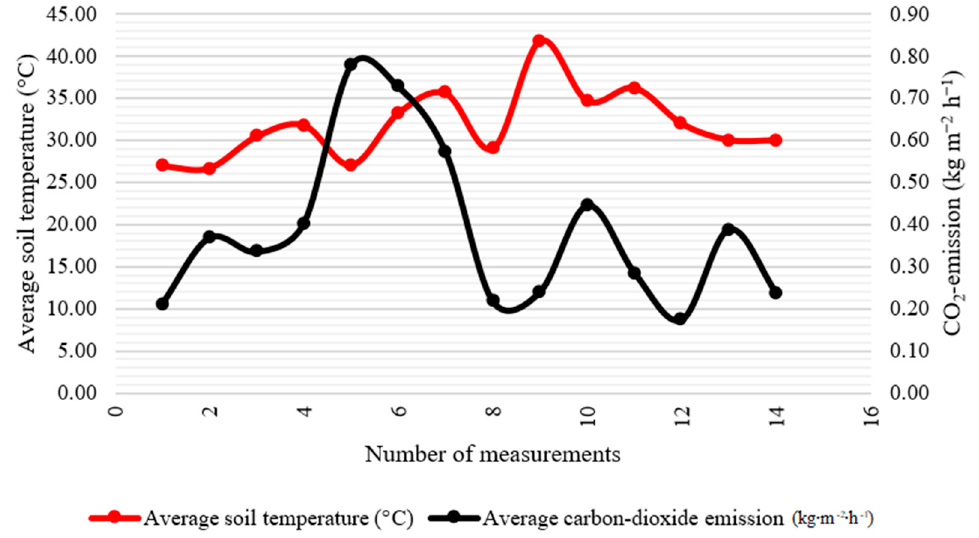
Figure 3. Soil temperature (°C) and carbon-dioxide-emission (kg · m − 2 · h − 1 ) results for the 2019 study period, independent of treatments (Karcag).